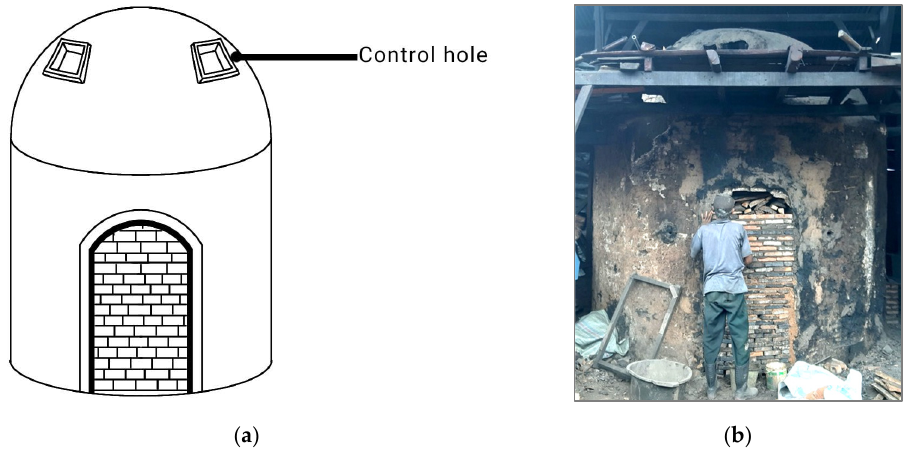
Figure 1. ( a ) The design of the dome kiln, and ( b ) the preparation activities before the pyrolysis